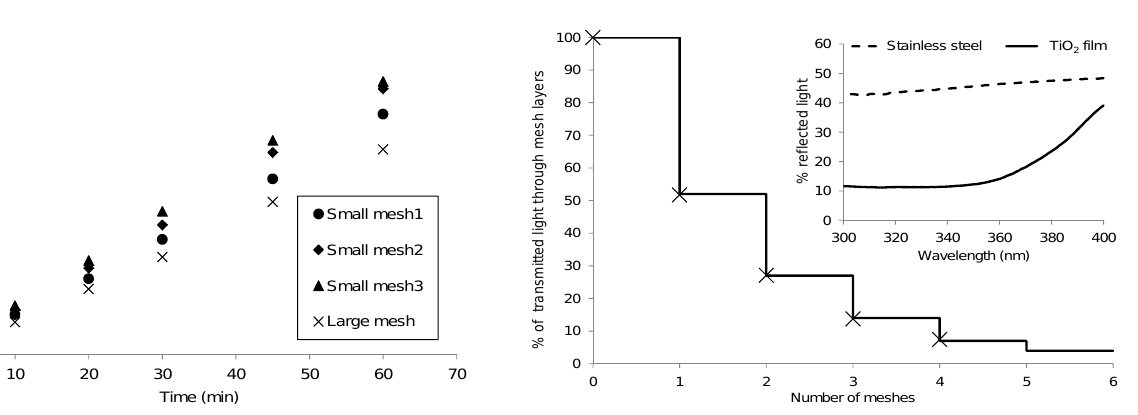
Figure 8. Maximum PL intensity at 425nm as a function of time for three single woven disc meshes and single woven sheet (19cm × 32cm), coated by EPD, after corrections for area-to- volume ratio.